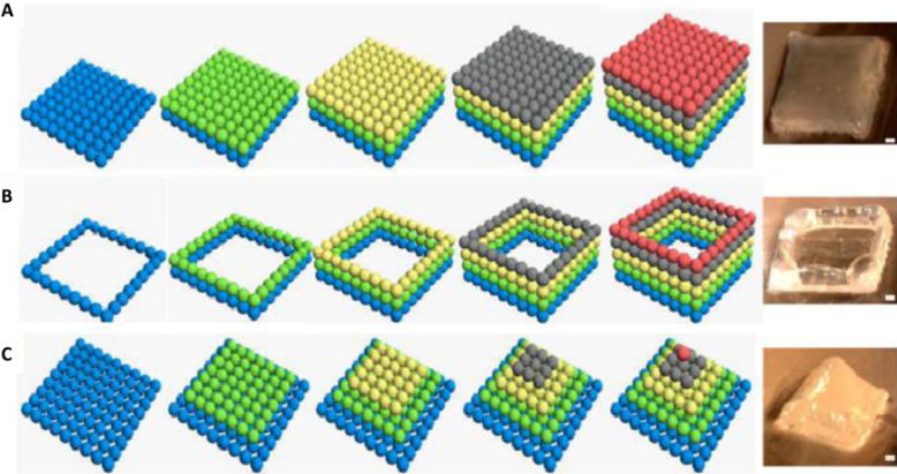
Figure 3. Formation of scaffolds fabricated through inkjet 3D printing of alginate hydrogels through varying geometries: ( A ) square model ( B ) pyramid model and ( C ) scale bar. (1 mm) [1]. Reprinted with permission from Ref. [1]. Copyright 2015, John Wiley, and Sons.